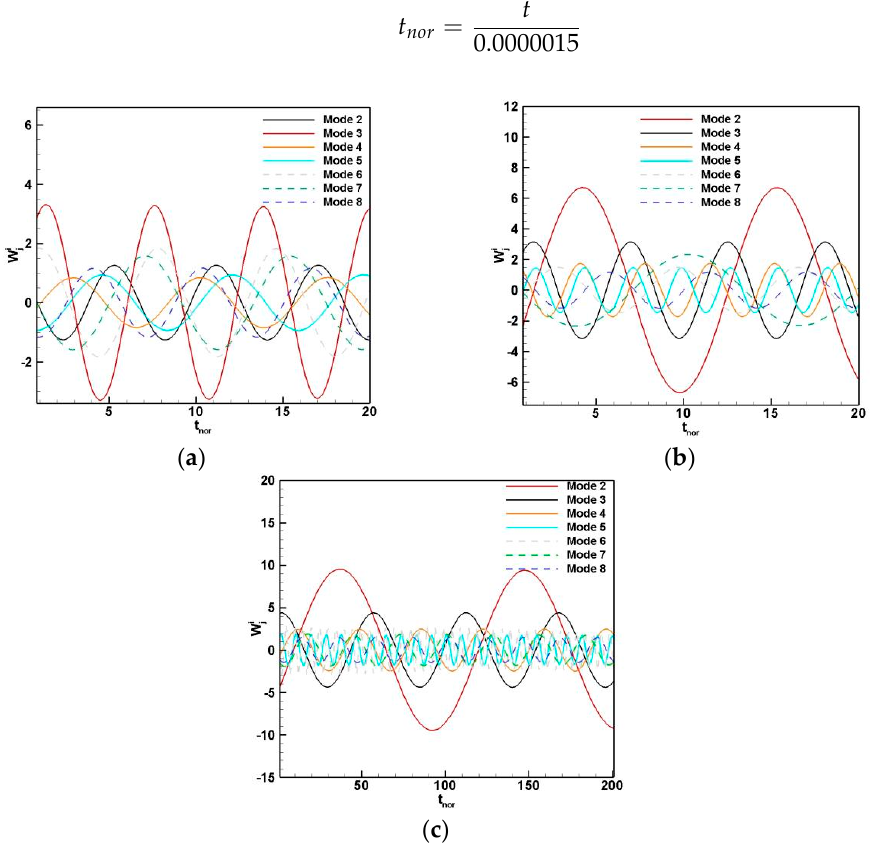
Figure 18. Evolution of time coefficients among seven dominant DMD modes: ( a ) Case 1; ( b ) Case 2; ( c ) Case 3.